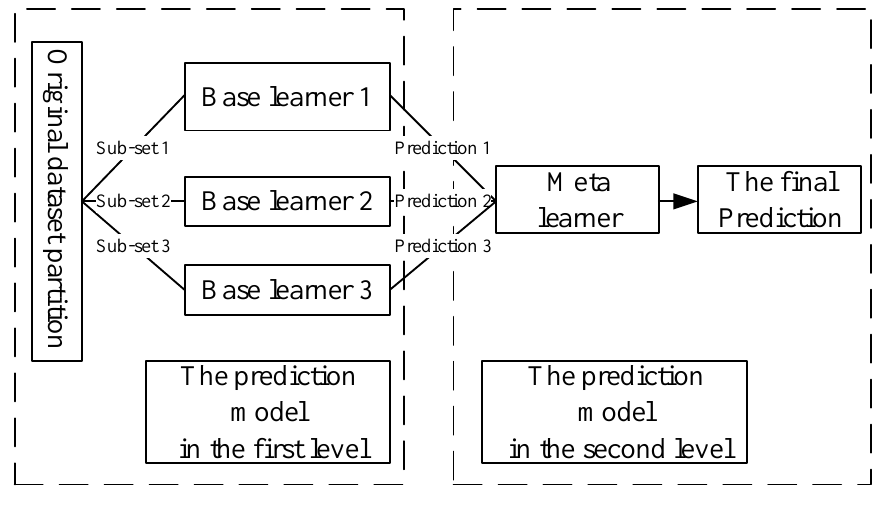
Figure 2. The architecture of